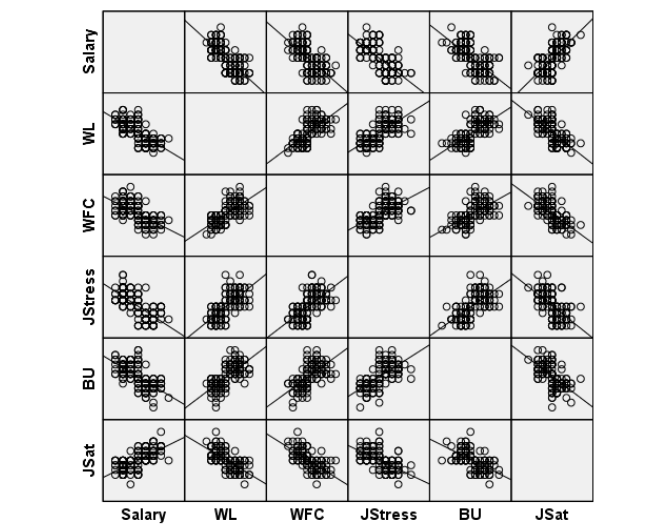
Figure 2. Linearity results